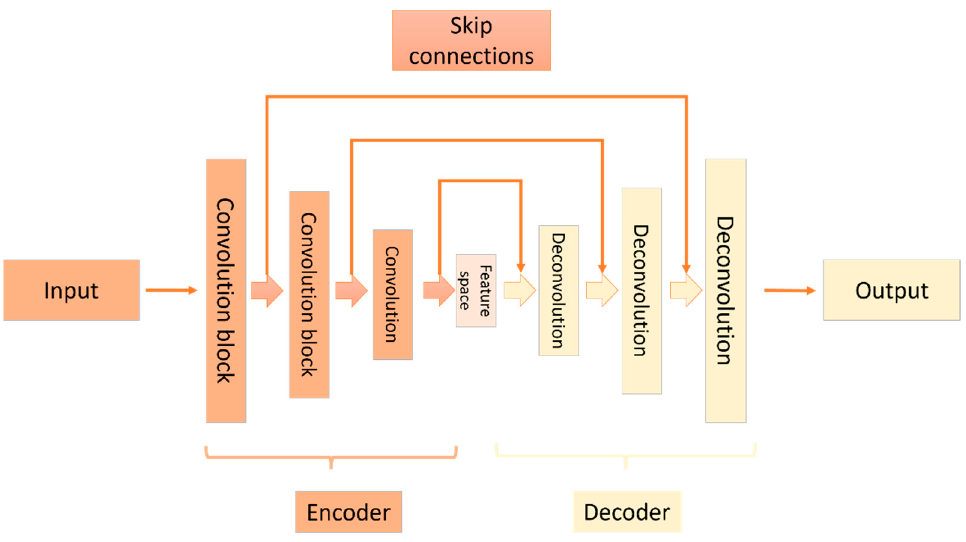
Figure 3. Encoder–decoder deep neural network architecture with skip